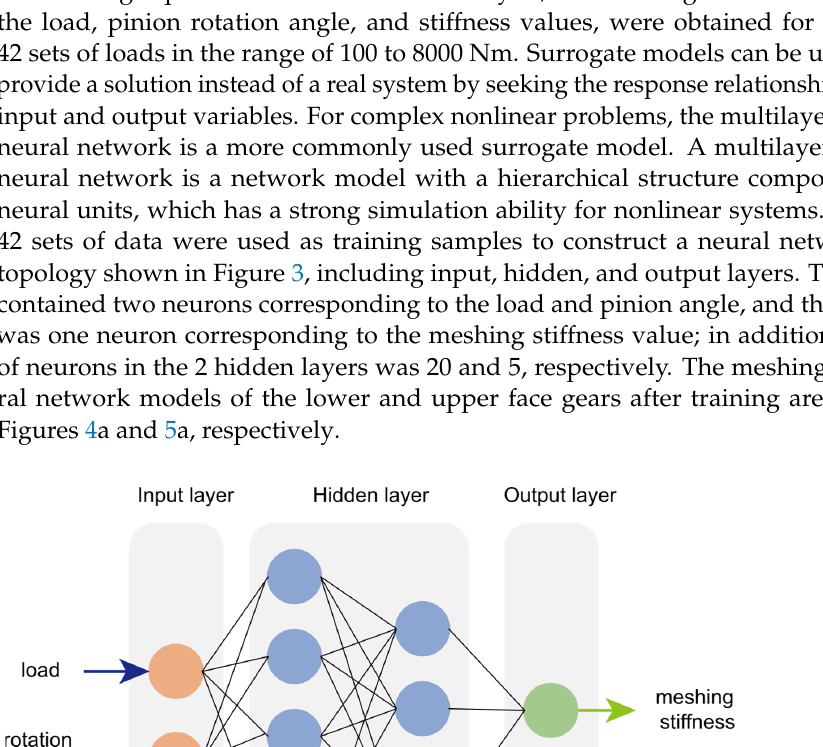
Table 1. Main design parameters of face gear pair.